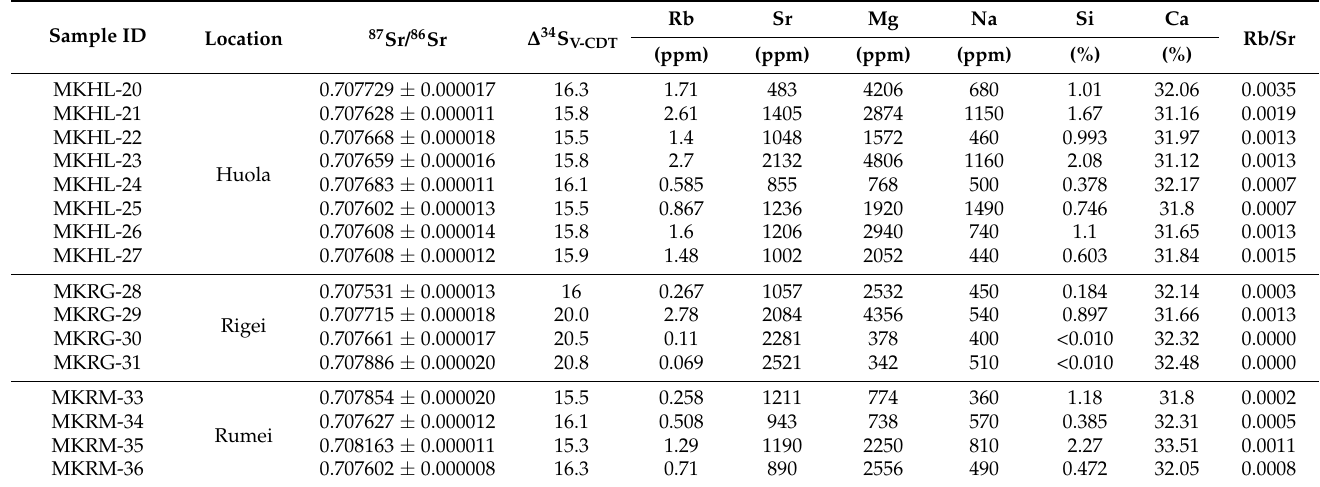
Table 2. Sr and S isotope compositions and trace elements of sulphate samples from Middle Jurassic Dongdaqiao Formation, Qamdo